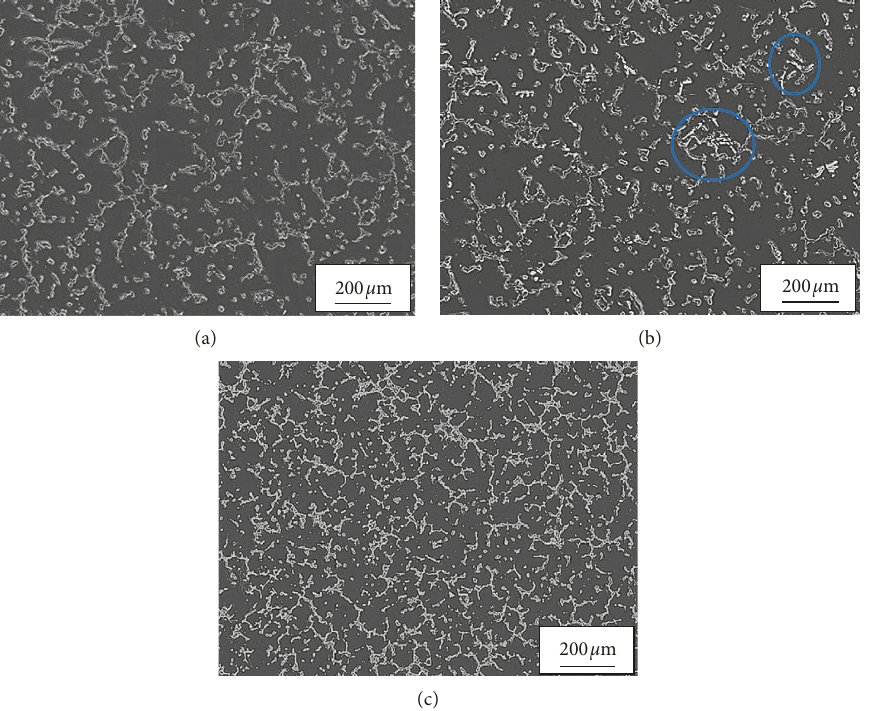
Figure 4: Photos of AZ91D magnesium alloy and Cu-SiC p /AZ91D magnesium matrix composites: (a) AZ91D, (b) Cu-SiC p /AZ91D, and (c) pulsed electric field +Cu-SiC p